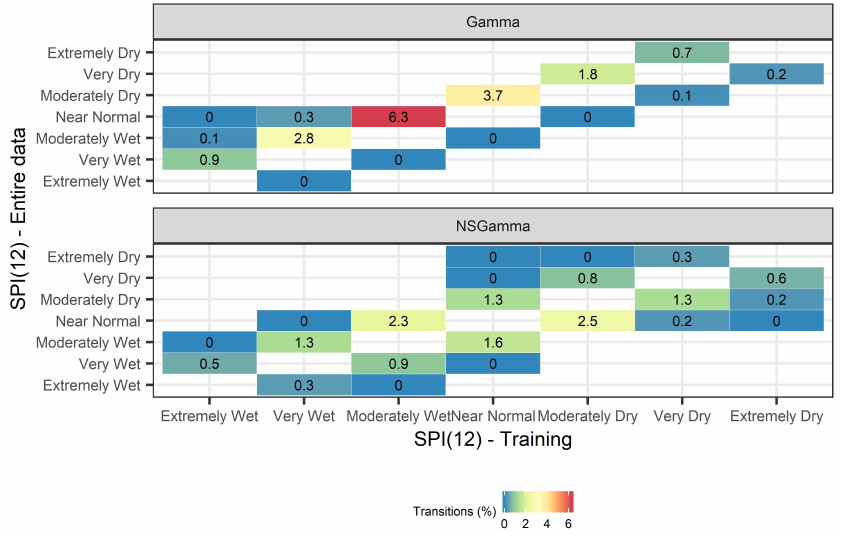
Figure 6. Transition of drought classes from Y ( 12 )( k ) ( x -axis) to Y ( 12 )( k , l , m ) ( y -axis) for 36,662 basins in Sweden during the period 1961–2018. Blue color leads to changes of lower magnitude while red color leads to changes of higher